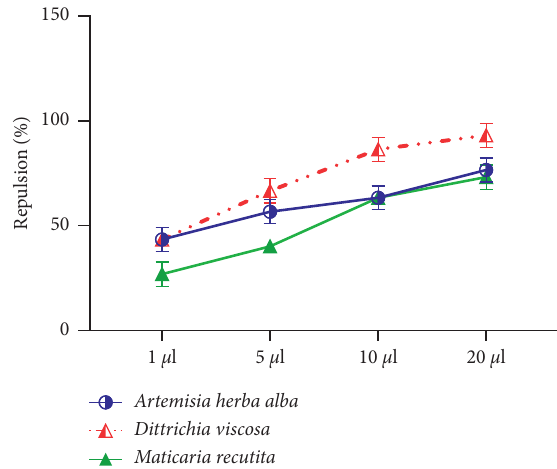
Figure 15: Repulsive effects of essential oils against Callosobruchus maculatus